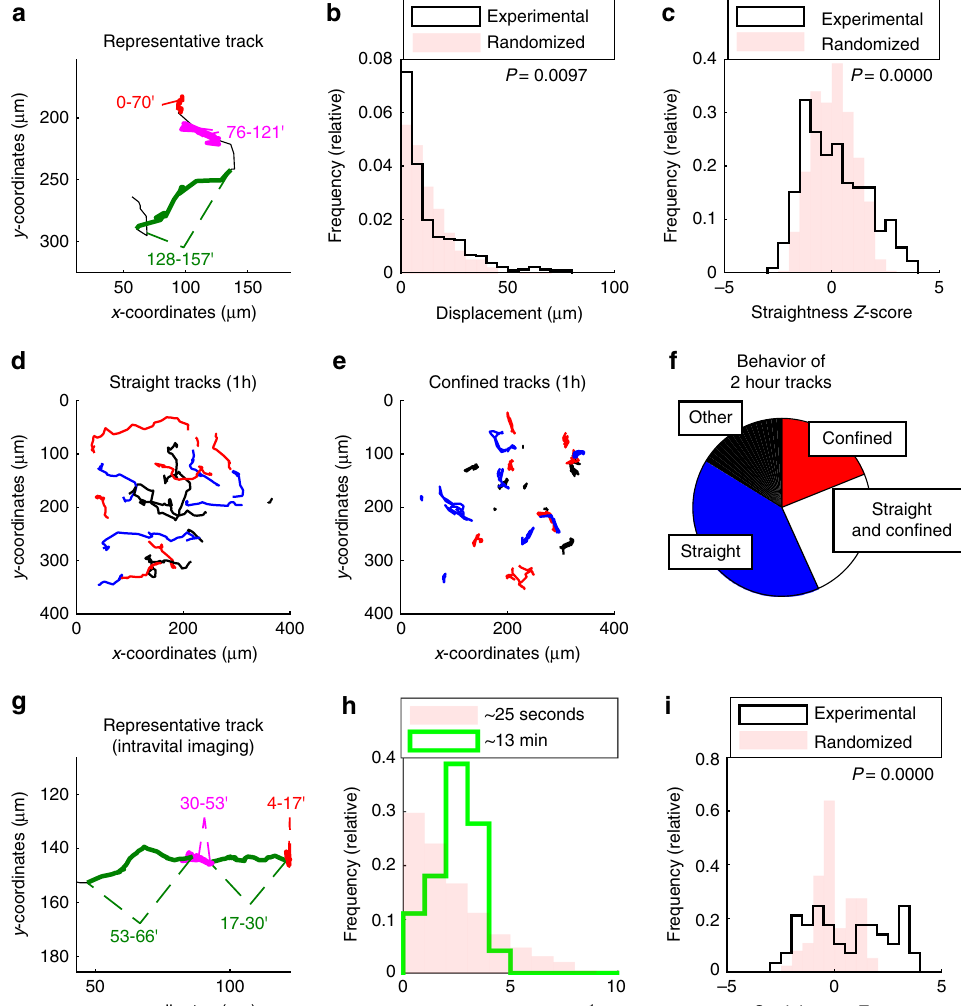
Fig. 4 Lung-in fi ltrating T cells switch between straight and con fi ned migration. GFP + effector T cells were injected i.v. into LPS-treated mice. After two to fi ve days, lungs were explanted ( a – f ) and imaged with two-photon microscopy or imaged using intravital microscopy ( g – i ). a Representative track displaying straight ( green ) and con fi ned ( red and magenta ) migration. Numbers indicate time in minutes. b , c Analysis of displacement ( b ) and straightness Z -score ( c ) of 15 min tracks ( n = 477 tracks). P -values were computed with the Kolmogorov – Smirnov test. d , e Analysis of 1 h tracks ( n = 94 tracks). Depiction of ‘‘ straight ’’ ( d ; straightness Z -score > 1.7) and ‘‘ con fi ned ’’ tracks ( e ; straightness Z -score < − 0.9). f Two hour tracks ( n = 37) were analyzed for switching between con fi nement and straight migration. Quantitative analyses from a – f were performed on pooled data obtained from three independent experiments. g – i GFP + effector T cells were injected i.v. into LPS-treated mice. After two to fi ve days, lungs were imaged with intravital two-photon microscopy. g Representative track displaying straight ( green ) and con fi ned ( red and magenta ) migration. Numbers indicate time in minutes. h Shown are histograms of the mean speeds of 13 min ( n = 154 tracks; median speed: 2.4 µ m min − 1 ) and 25 s ( n = 5194 tracks) tracks. i Analysis of straightness Z -score (track duration approximately 13 min) before and after randomization of velocity vectors ( n = 154 tracks). P -value was computed with the Kolmogorov – Smirnov test. A total of three movies obtained from different mice were analyzed in g –